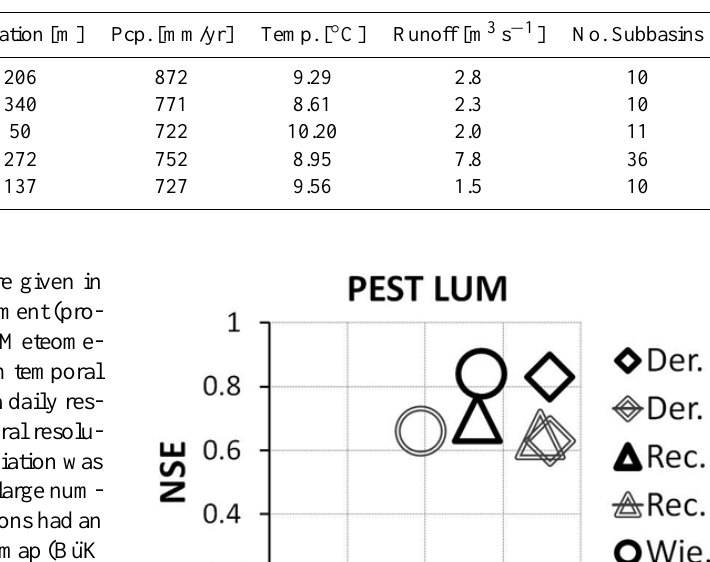
Table 1. Characteristics of the catchments (mean values for precipitation, temperature and runoff).